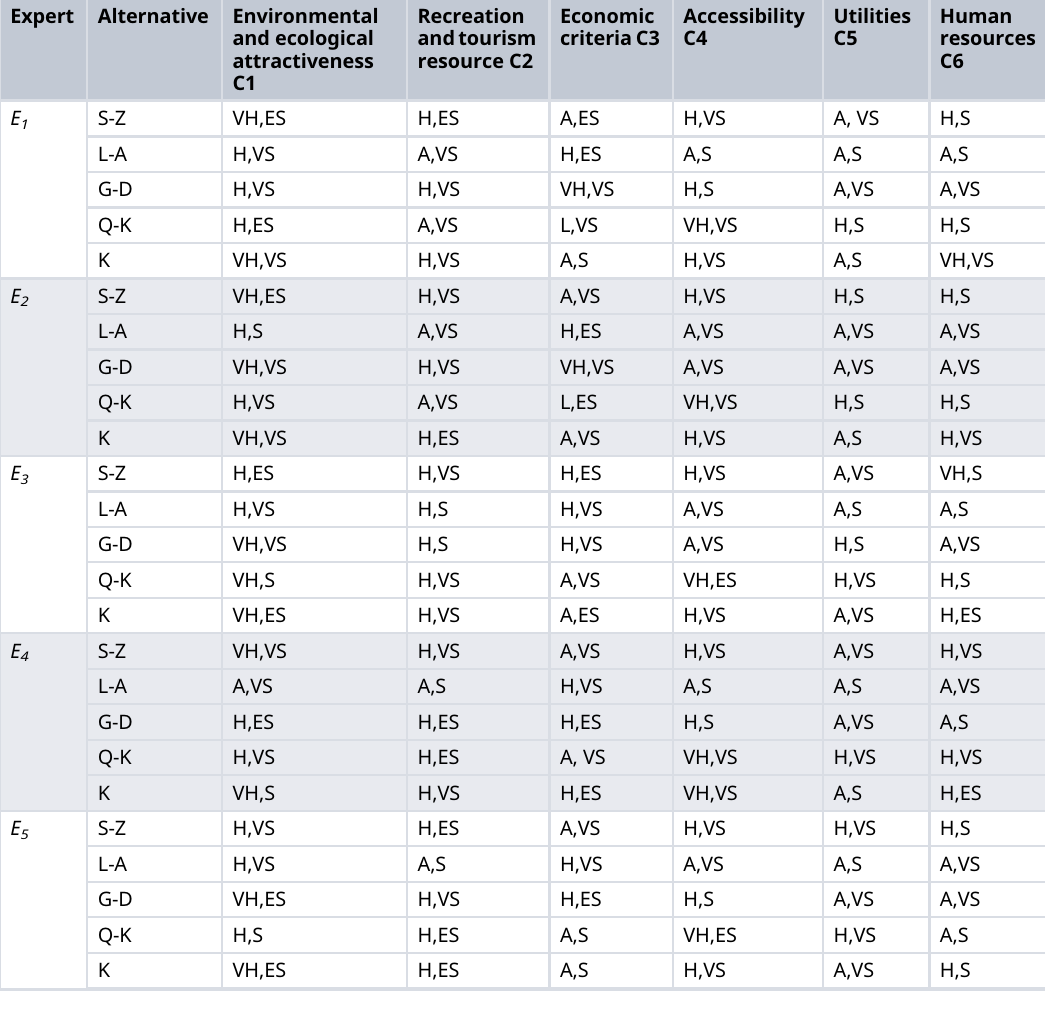
Table 3. Z-number based value of criteria for all alternatives. Expert Alternative Environmental and ecological